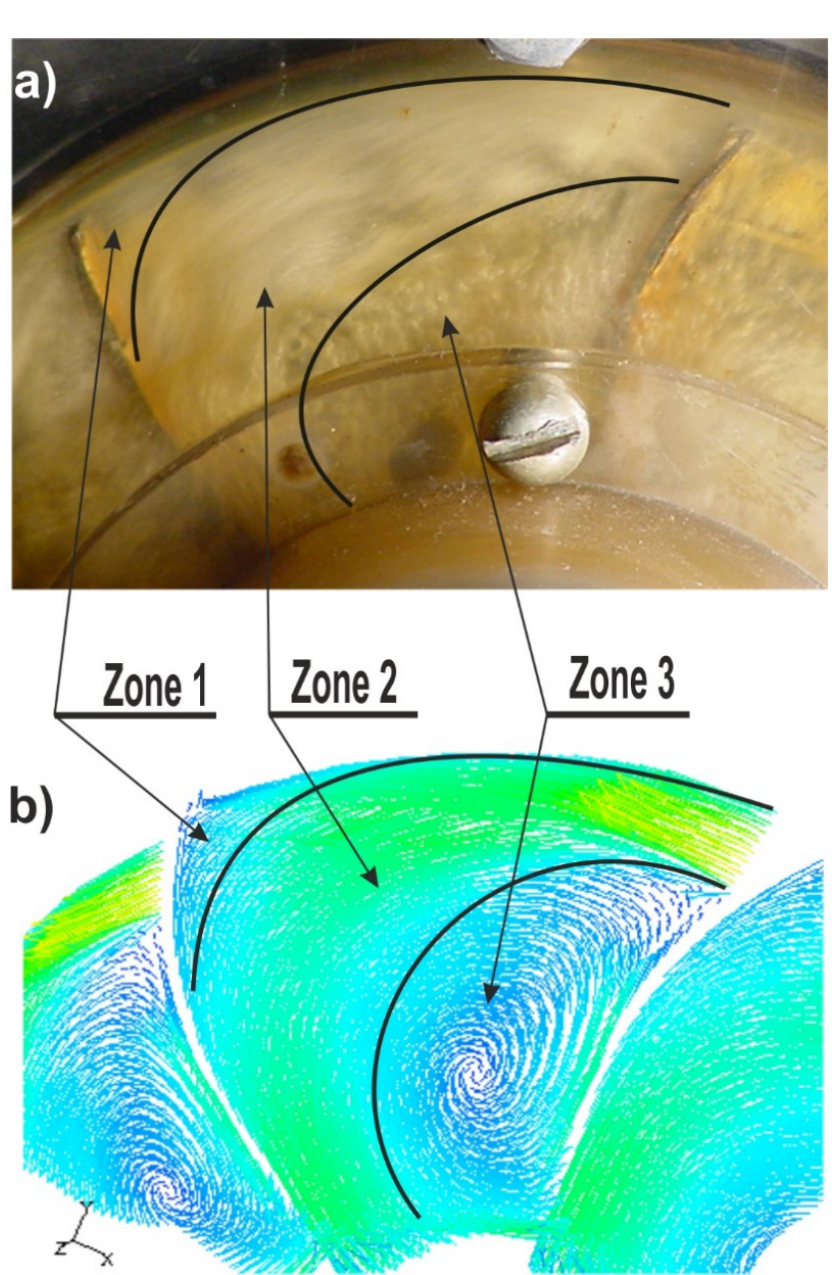
Figure 18. The structure of flow in the return channels obtained: ( a ) from the experiment; ( b ) from the calculations.